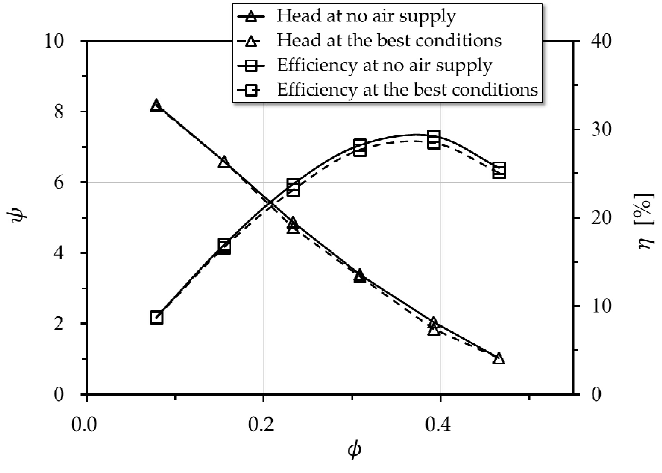
Figure 10. Effect of the suction air flowrate on the pump performance.